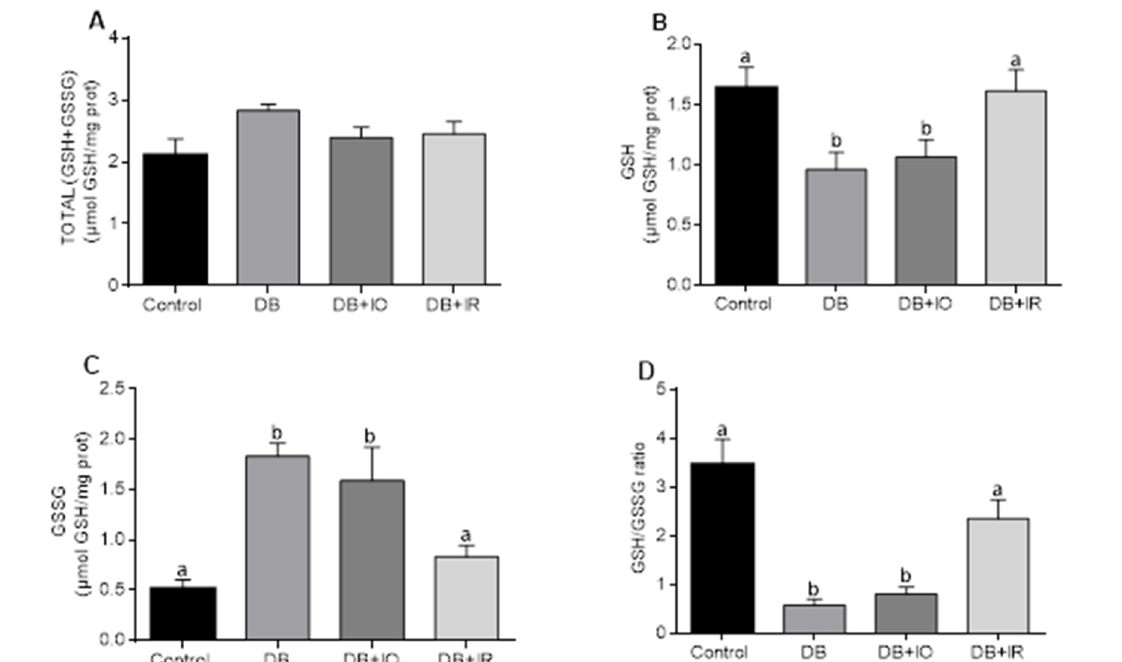
Figure 7. Effects of dietary iron on total glutathione ( A ), reduced glutathione (GSH) ( B ), oxidized glutathione (GSSG) ( C ), and GSH/GSSG ratio ( D ). Data are presented as group mean ± standard error. p < 0.05 ( n = 6, ANOVA plus Tukey’s post hoc test). Different letters (a,b) indicate statistically significant differences. DB + IO, diabetic rats with iron overload; DB + IR, diabetic rats with iron restriction diet.